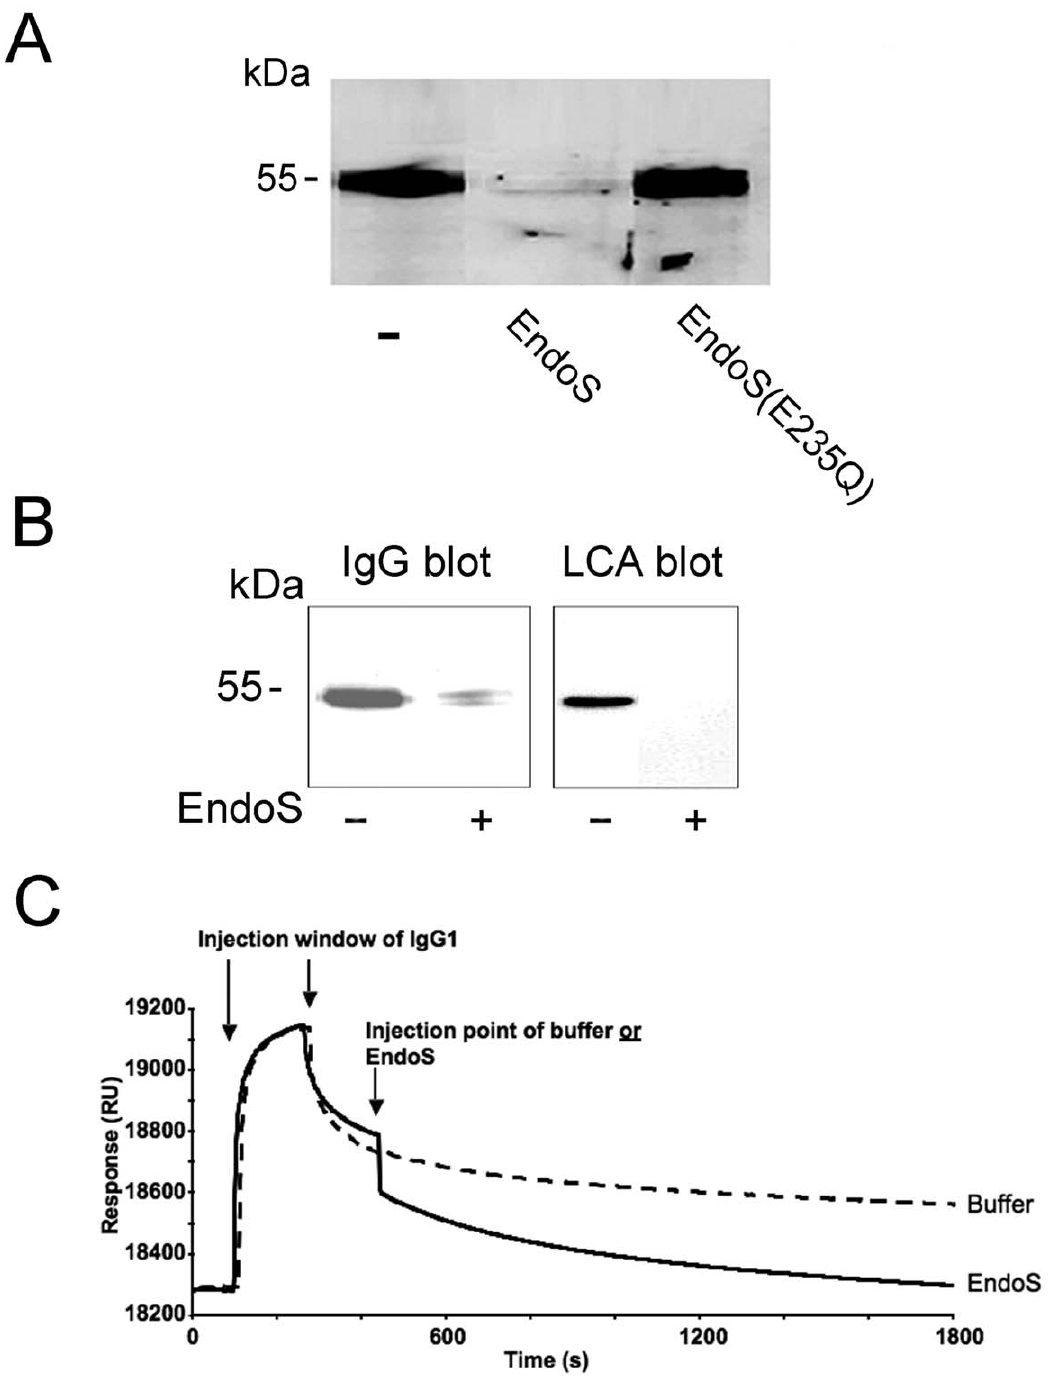
Figure 7. Dissociation of IgG from Fc c RII upon treatment with EndoS. Panel A. IgG bound to K562 cells dissociates from Fc c RIIa upon incubation with EndoS but not with EndoS(E235Q). K562 cells were incubated with plasma and subsequently with EndoS, EndoS(E235Q) or PBS. Cell lysates, 10 m g total protein, were analysed for IgG by SDS-PAGE and blot using antiserum against human IgG. Panel B. IgG bound to monocytes dissociates from Fc c Rs after treatment with EndoS. Monocytes were incubated with plasma and later with EndoS or PBS. Resuspended cell pellets were analyzed for IgG by blot using antiserum against human IgG. The glycan of IgG was detected by blot and reactivity with LCA lectin. Panel C. A BIAcore setup showing EndoS affecting the IgG1 dissociation from an immobilized receptor Fc c RIIa. In two parallel experiments, the injection of EndoS (black curve) is compared to the injection of buffer (broken line) at the same time-point during the dissociation phase of the IgG1- Fc c RIIa interaction.